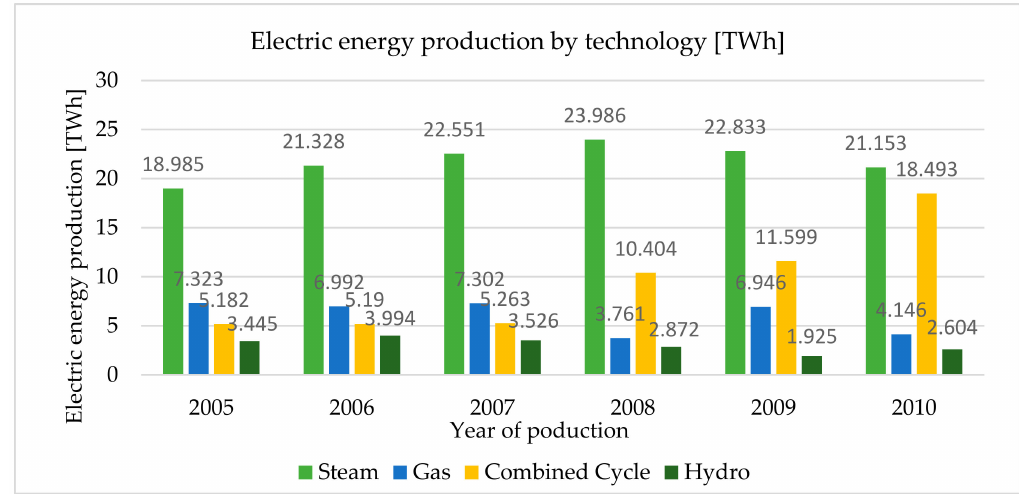
Figure 4. Electric energy production by technology in the period 2005–2010.